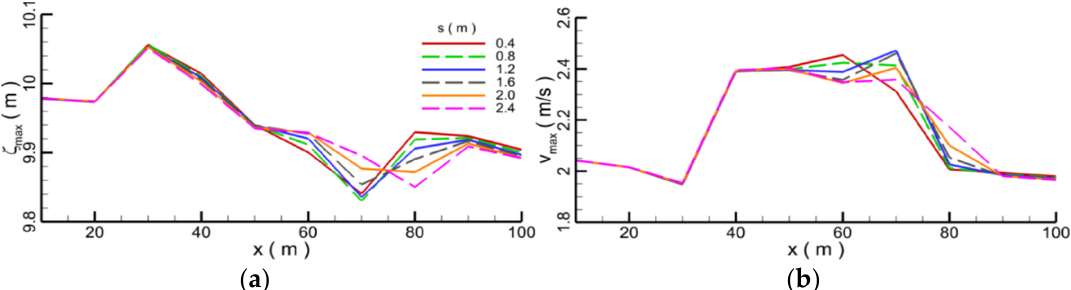
Figure 17. The maximum water level and velocity recorded with different distances; ( a ) water level; ( b ) velocity.